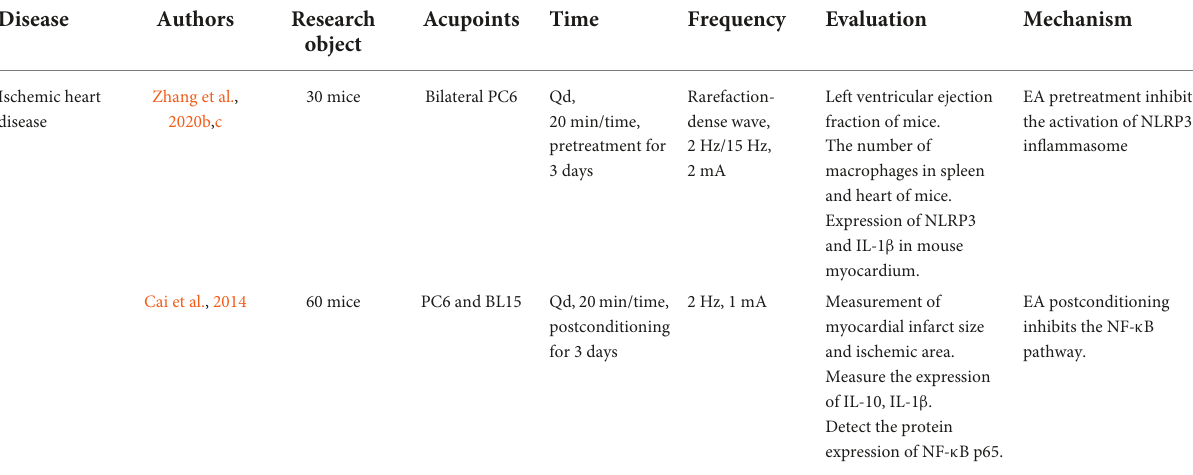
TABLE 3 Mechanism of electroacupuncture targeting NLRP3 inflammasome in the treatment of ischemic heart disease.